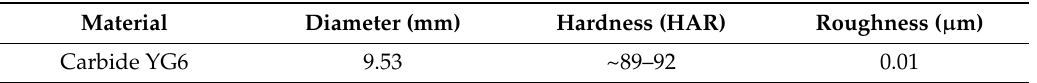
Table 4. Range of experimental conditions.